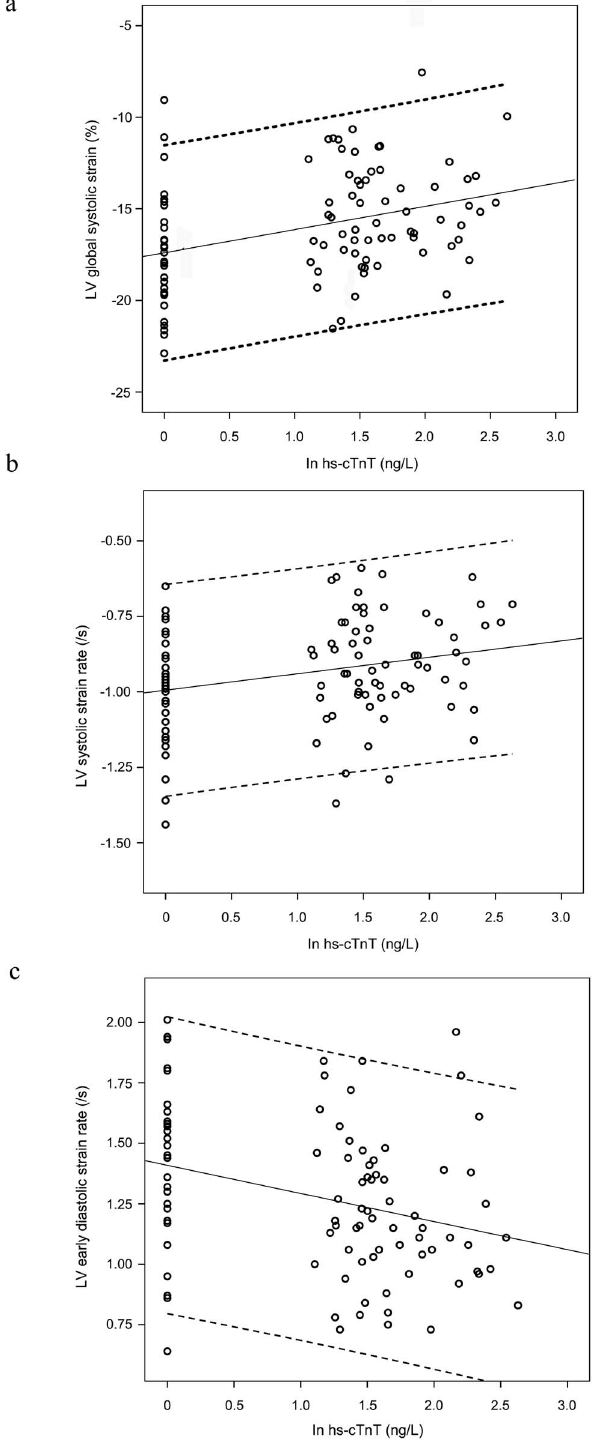
Figure 3. Relationships between high sensitivity cardiac troponin T (hs-cTnT) and indices of left ventricular (LV) deformation. Correlations between hs-cTnT and LV (a) global longitudinal systolic strain, (b) systolic strain rate, and (c) diastolic strain rate are shown. Solid lines represent the best-fit linear regression and dashed lines represent the 95% confidence interval for each parameter of the regression line.